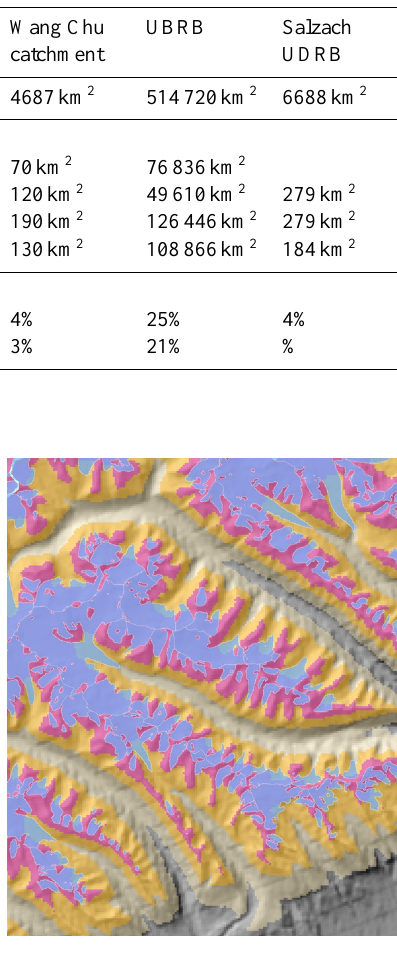
Figure 4. Detailed map of modelled increase of permafrost limit using IPCC scenario A1B, Lhasa